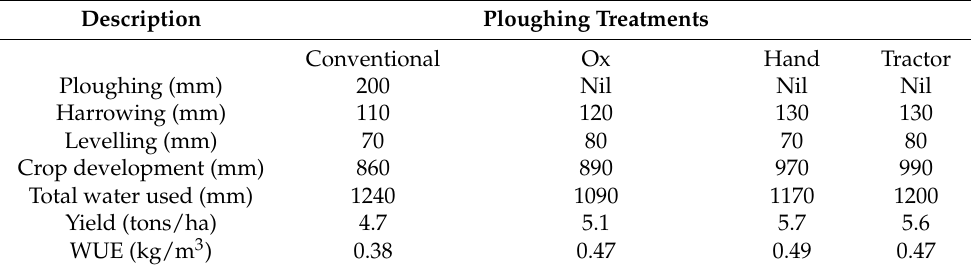
Table 3. Mean water used and rice yield for different ploughing